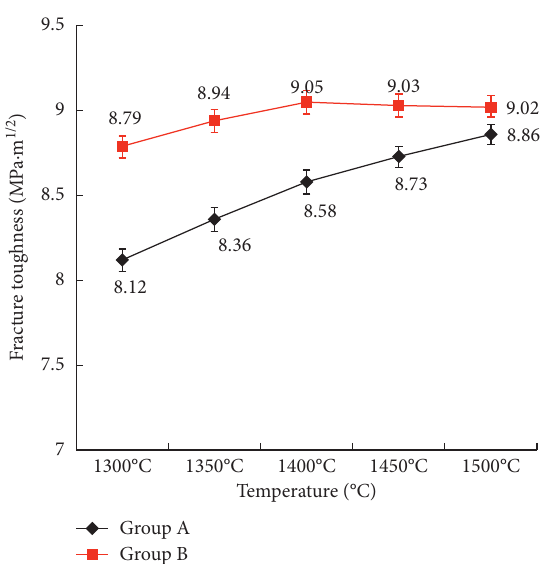
Figure 15: Fracture toughness of samples at different microwave sintering